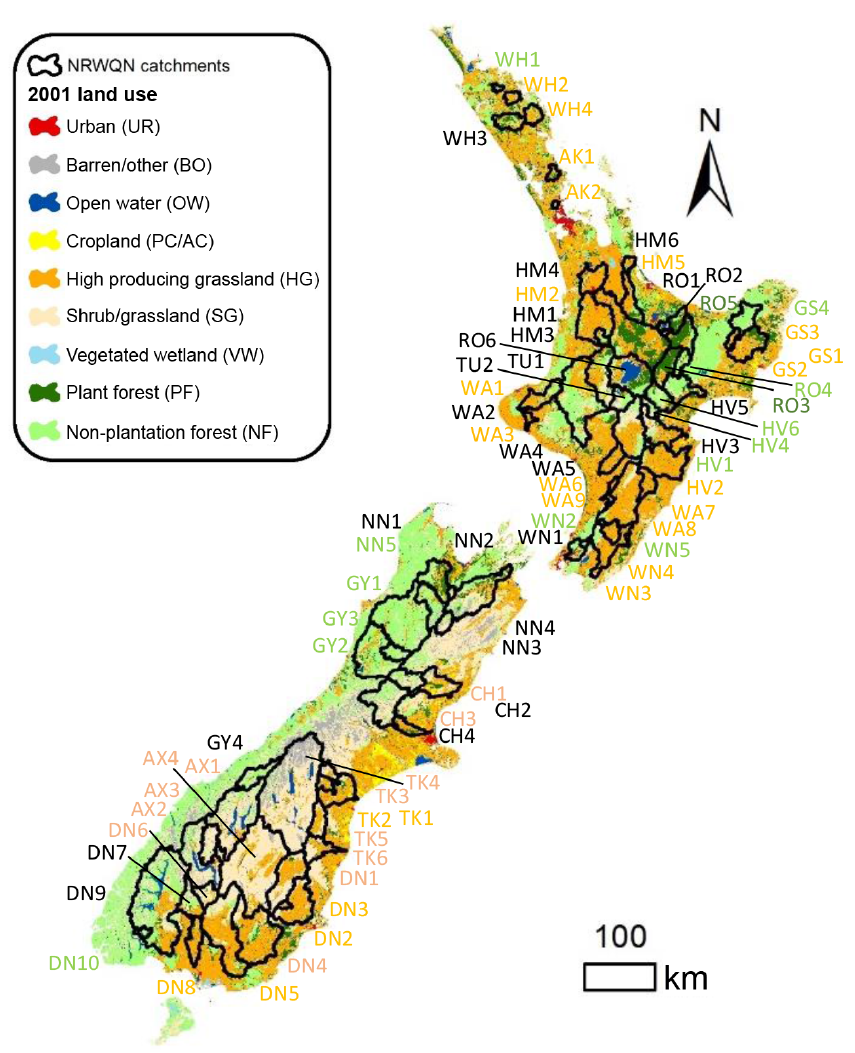
Figure 1. Land use and location of the 77 National River Water Quality Network (NRWQN) catchments. Catchment ID colors refer to dominant land use (>50%). Catchments with no dominant land use are